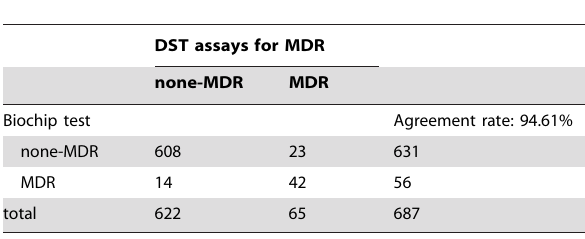
Table 3. Comparison of DST and biochip for MDR *